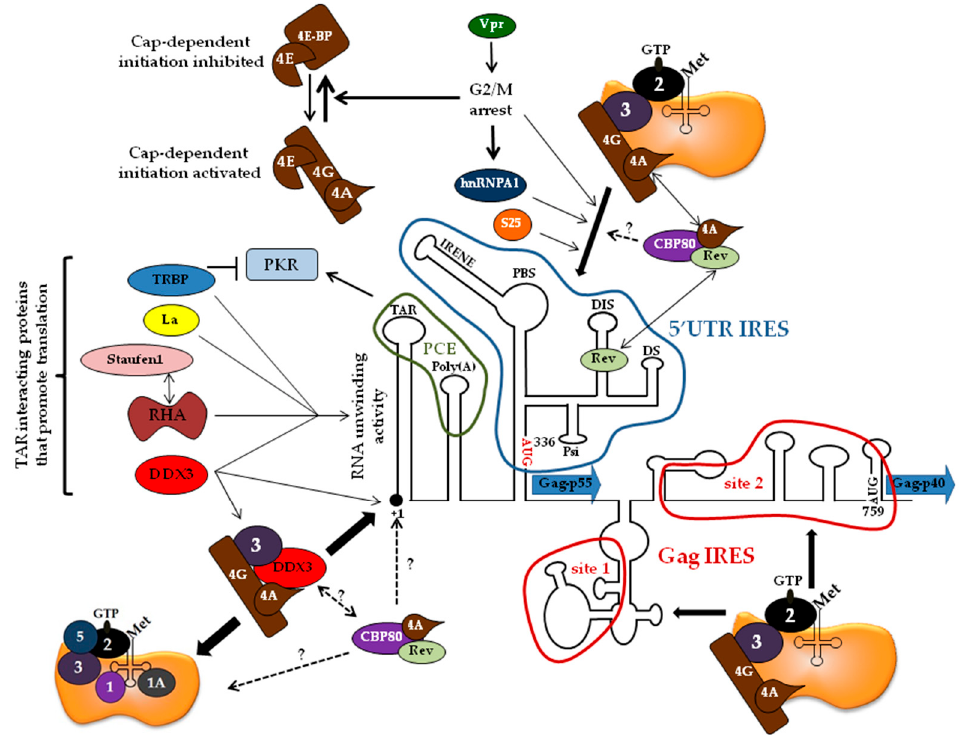
Figure 3. Translation initiation of the HIV-1 unspliced mRNA. Scheme of the RNA structures of the first ≈ 800 nt, which includes the 5 ′ UTR composed of the TAR, poly(A), PBS, DIS, SD, and Psi element required for viral replication, and the beginning of the Gag-coding region. The cap structure is at position +1 and the Gag-p55 and Gag-p40 initiation codons are located at positions 336 and 759, respectively. Cap-dependent translation is inhibited by the presence of the TAR element and needs the TAR interacting proteins (such as TRBP, La, Staufen1, RNA helicase A (RHA), and DEAD-box polypeptide 3 (DDX3)) to certainly promote RNA unwinding and ribosomal recruitment at the 5 ′ end of the mRNA. Two complexes composed of DDX3, eIF4G, eIF4A, and eIF3 on the one hand, and cap binding protein 80 (CBP80), Rev, and eIF4A on the other hand exist and could drive ribosome recruitment on the mRNA independently of eIF4E. The 5 ′ UTR IRES is depicted inside the blue line, and ribosome attachment can be promoted via hnRNPA1 and S25 proteins and is enhanced during cell cycle arrest in the G2 phase, which is induced by Vpr and induces the sequestration of eIF4E by 4E-BP. The two internal ribosome binding sites of the Gag-coding region are indicated inside the red lines and they drive expression of Gag p55 and Gag p40. The PCE and IRENE regions are also indicated.